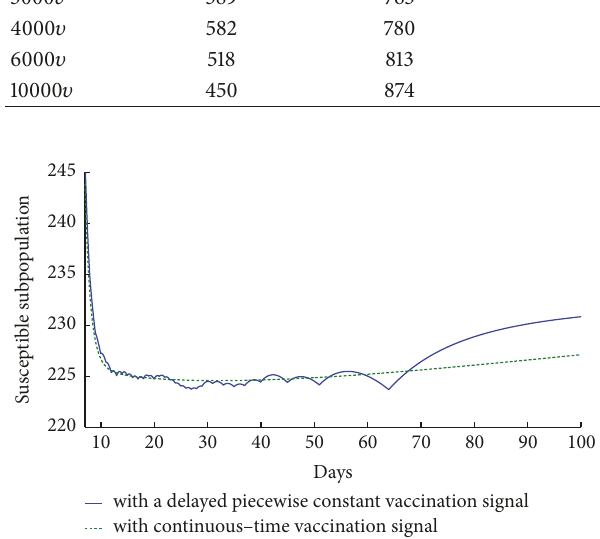
Figure 17: Susceptible subpopulation in the SISV model with two different vaccination signals: (i) a delayed piecewise constant signal taking integer values and (ii) continuous-time signal.